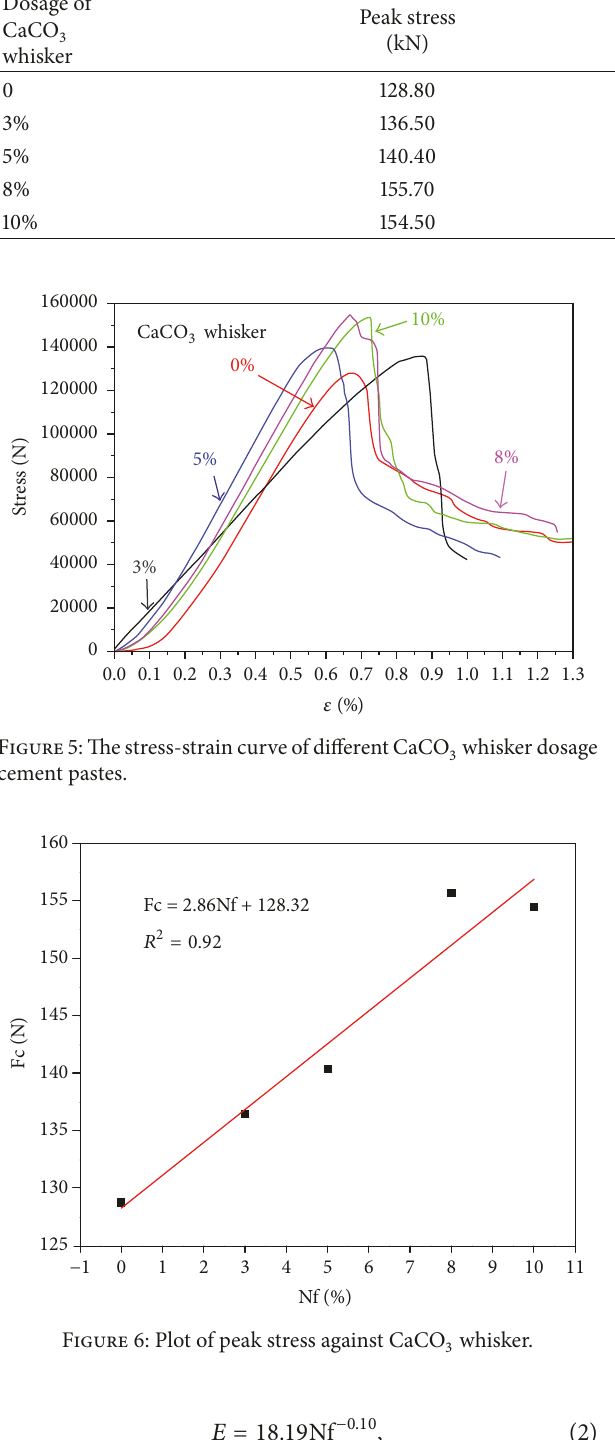
whisker were at different dosage, the basic geometrical char- acteristics and processes of the uniaxial compression test